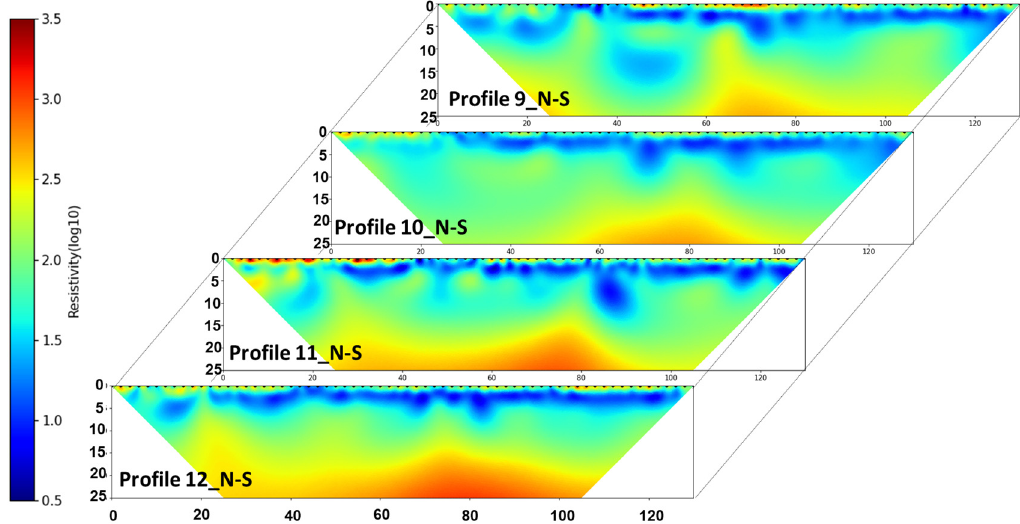
Figure 10. Resistivity models along transects 9 to 12 acquired in the north–south direction.